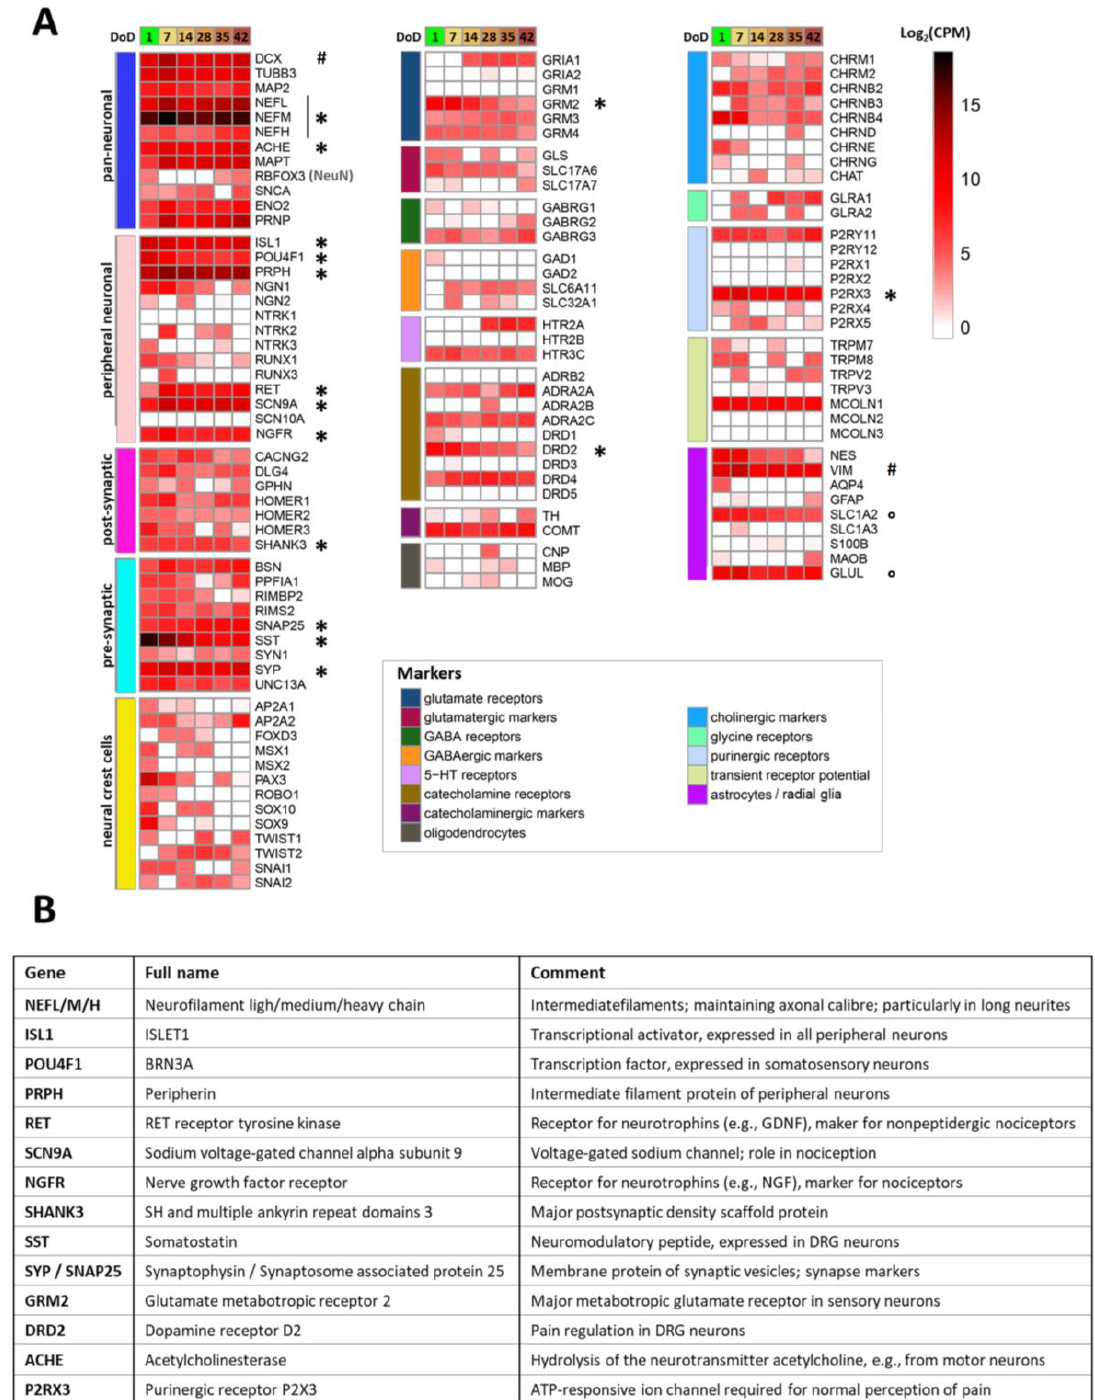
Figure 4. Transcriptome profiling of Si28-NGN1-derived sensory neurons. Neurons were pre-differentiated to immature sensory neurons and frozen. ( A ) After thawing, gene expression levels were determined for 6 differentiation stages (on day of differentiation (DoD) 1, 7, 14, 28, 35 and 42) by the TempO-Seq method. The heatmap visualizes the normalized counts for each gene (rows) and the DoD (columns). The neuronal overview panel of 122 genes is clustered by gene groups (e.g., neuronal/glial subtypes, and receptor/ion channel classes). The gene groups are indicated by color bars (left). The absolute expression levels are given in counts of the corresponding gene per 1 million reads (CPM). The color scale uses log 2 (CPM) units (see the supplementary files for complete data sets) and ranges from white (no expression) to dark red (high expression). Data are derived from 3 independent differentiations. A subset of genes that that may be used for routine culture controls is highlighted (*). High expression levels of VIM and DCX (#) indicate a still relatively young state of